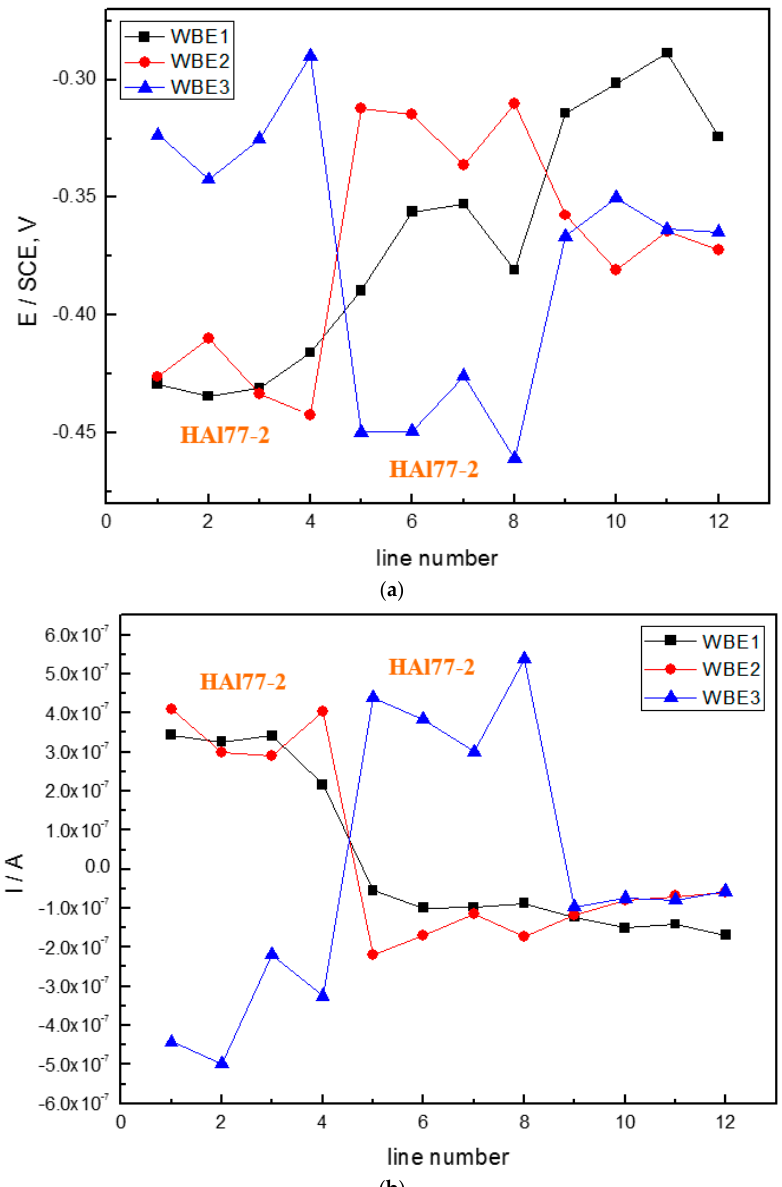
Figure 22. ( a ) Average potential; and ( b ) current–density distribution of each microelectrode line after being coupled for 12 h in artificial seawater with 2.7 wt % Cl − at 70